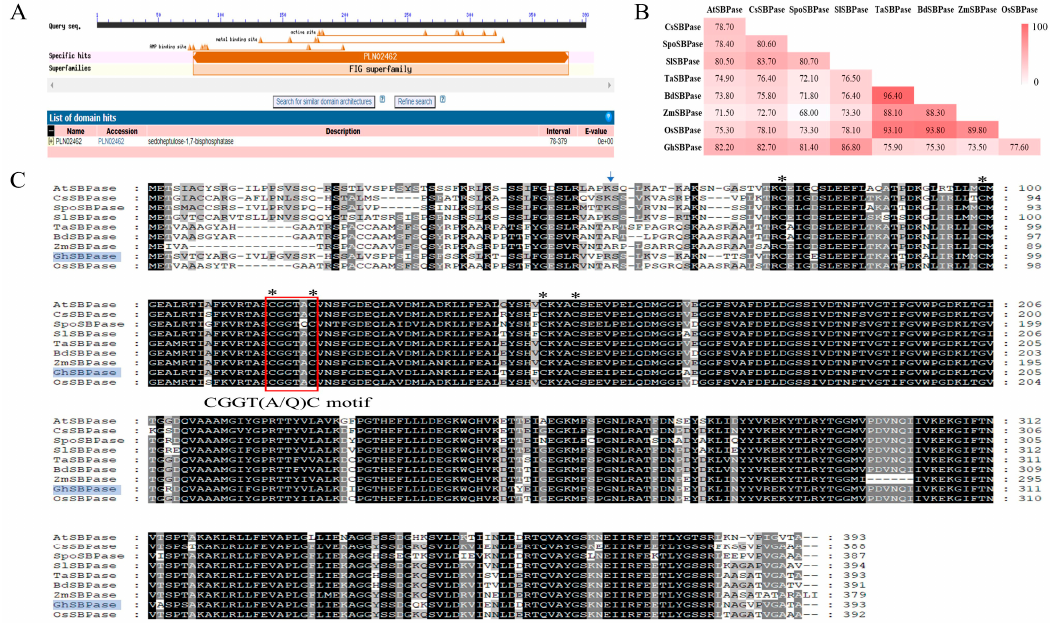
Figure 3. Conserved domain and sequence identity analysis of GhSBPase protein in upland cotton. ( A ) Conserved domain prediction of GhSBPase protein. ( B ) The sequence identity between GhSBPase protein and SBPase proteins in other plants. ( C ) Muti-sequence alignment of plant SBPase proteins. The symbol * represents cysteine; the blue arrow refers to the cutting site of the chloroplast transport peptide of GhSBPase protein; the red box indicates CGGT(A/Q)C motif.